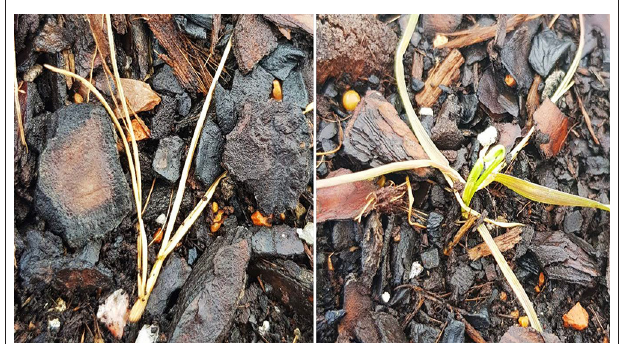
FIGURE 3 | Annual ryegrass three-leaf stage plants at 3 weeks post-laser treatment illustrating plants considered controlled (Left) and uncontrolled (Right) with new growth emerging from the uncontrolled growing